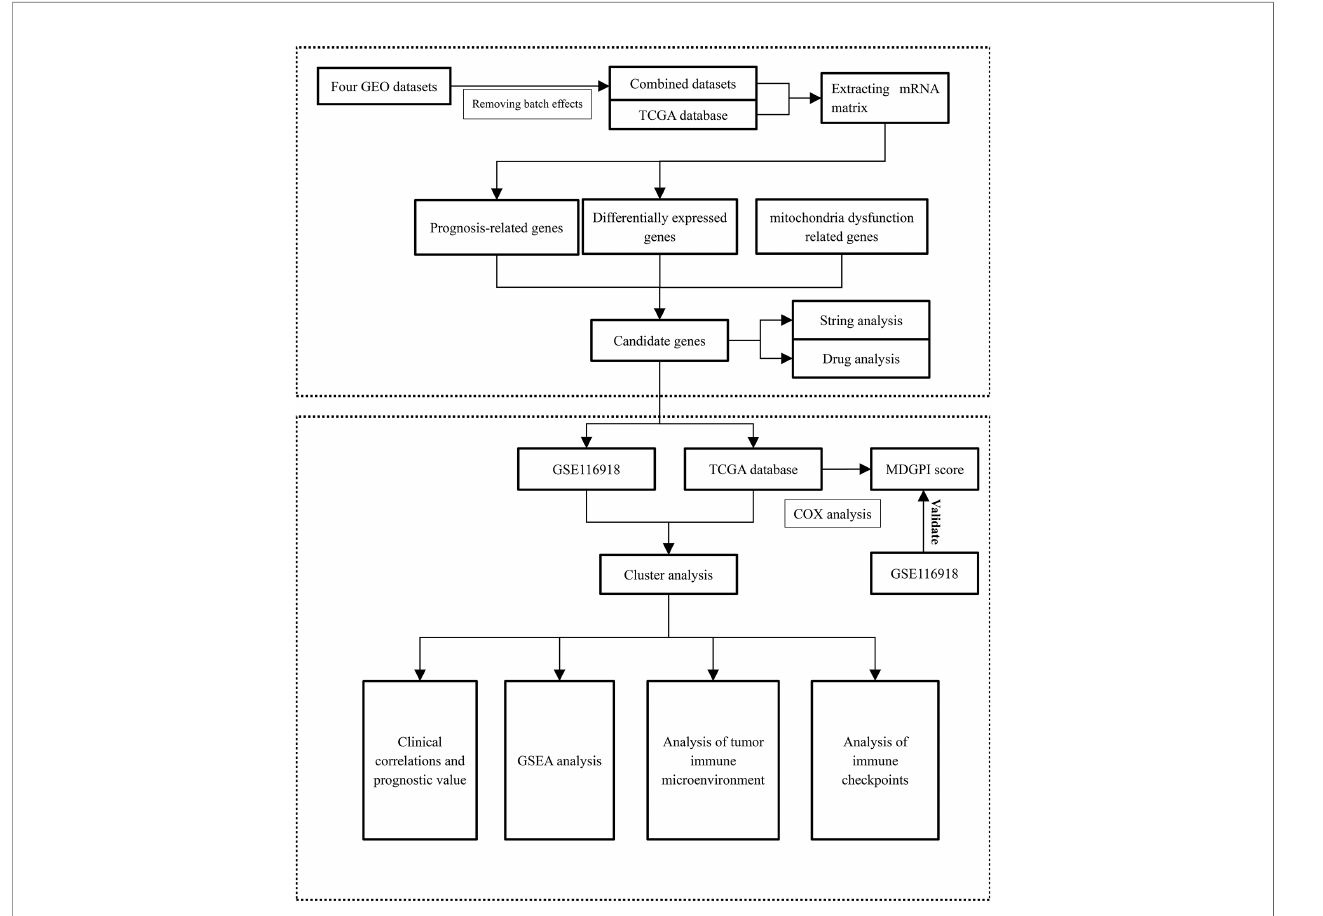
FIGURE 1 | The fl owchart of this study. GSEA, gene set enrichment analysis; MDGPI, mitochondrial dysfunction genetic prognostic index; GEO, Gene Expression Omnibus; mRNA, messenger